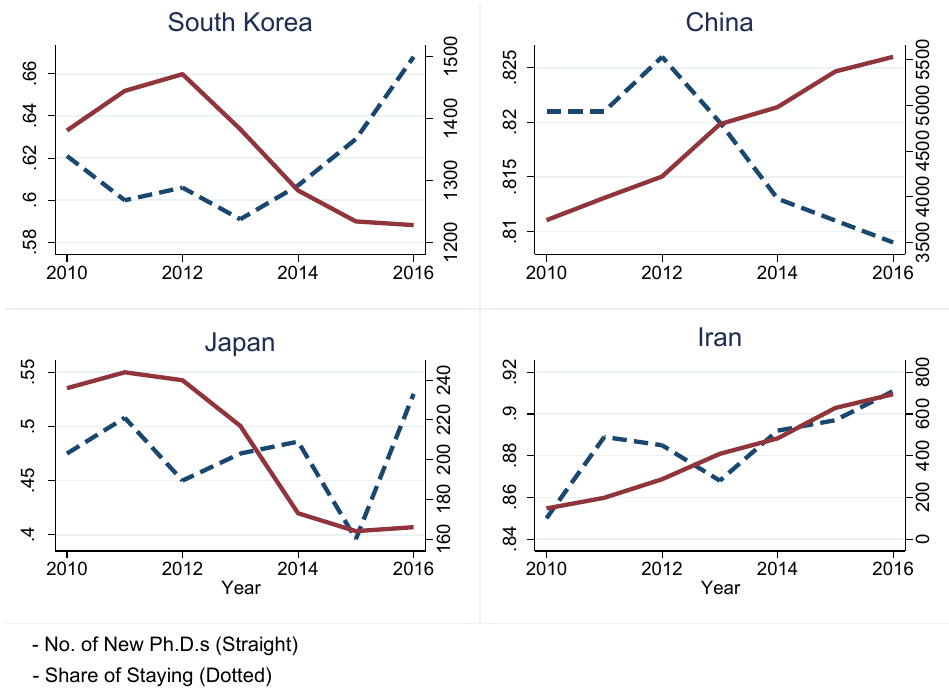
Figure 2. Number of U.S. Ph.D. recipients and the share of them intending to stay in the U.S. Source: U.S. National Science